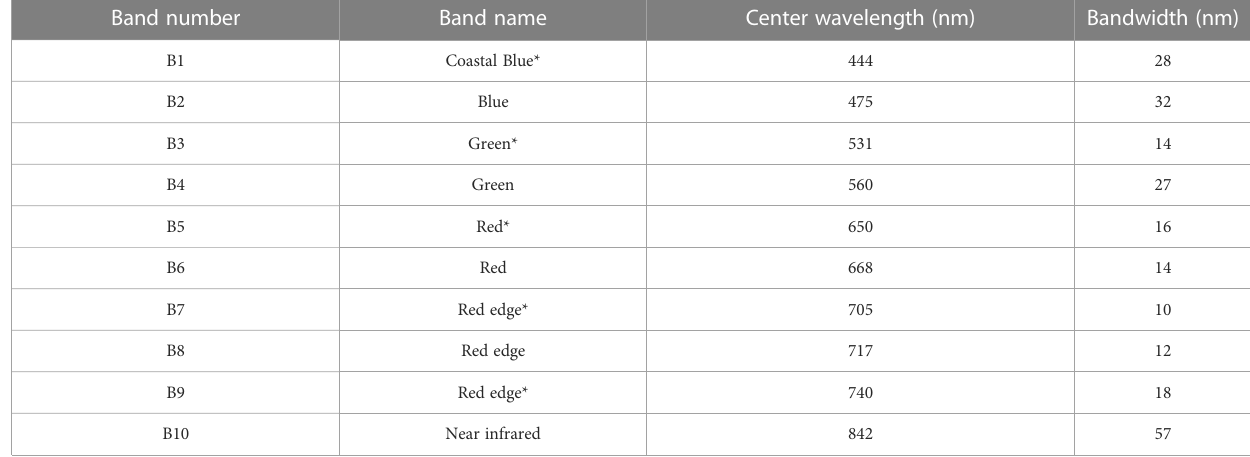
*Indicates the bands of the RedEdge-MX Blue